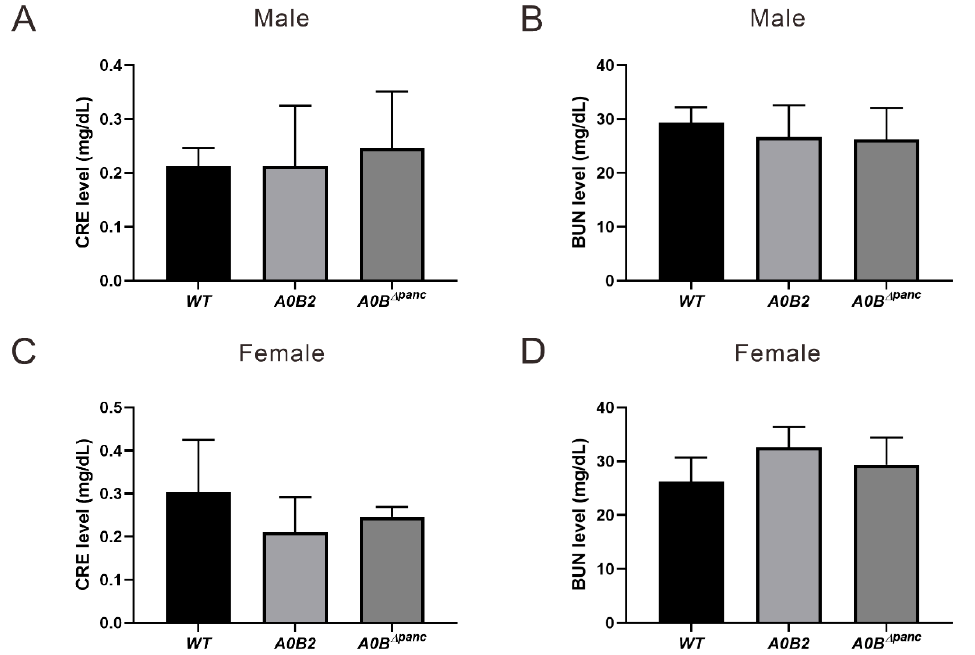
Figure 4. Metabolic parameters analysis. Blood samples drawn from the carotid artery were performed to analyze induced renal dysfunction evidenced by blood urea nitrogen (BUN) and serum creatinine (CRE) analysis at 16 weeks post-TAM injection, ( A , B ) male, ( C , D ) female. About 3–6 mice in each group were used. The error bars indicate SD.